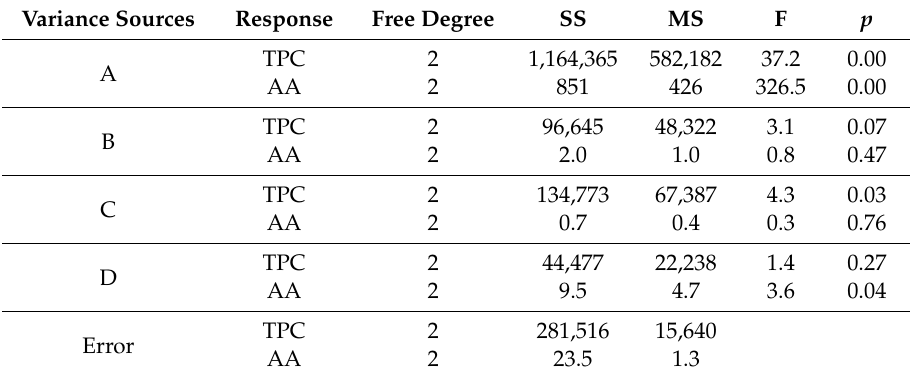
Table 6. Variance analysis of L 9 (3 4 ) orthogonal experiment for UAE.